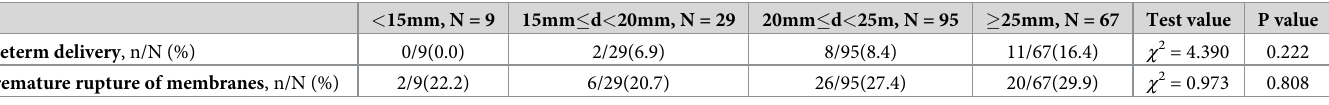
Table 5. The impact of cone floor transverse diameters on preterm delivery and premature rupture of membranes.